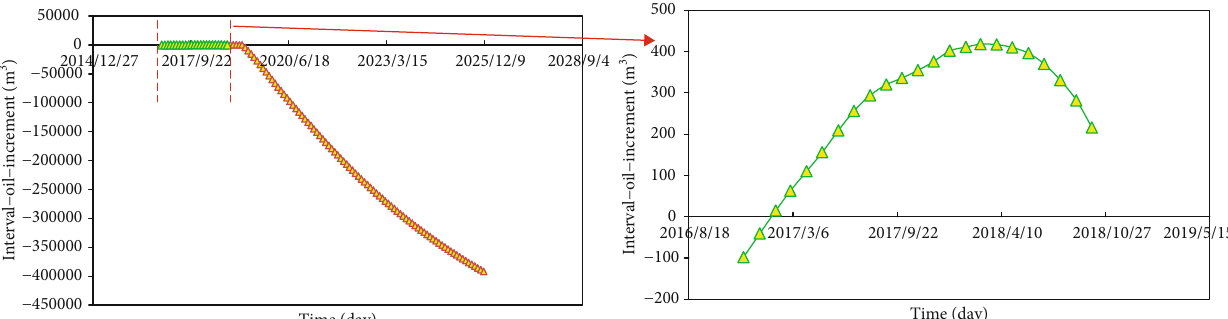
Figure 17: Change of water-polymer perturbation coe ffi cient.